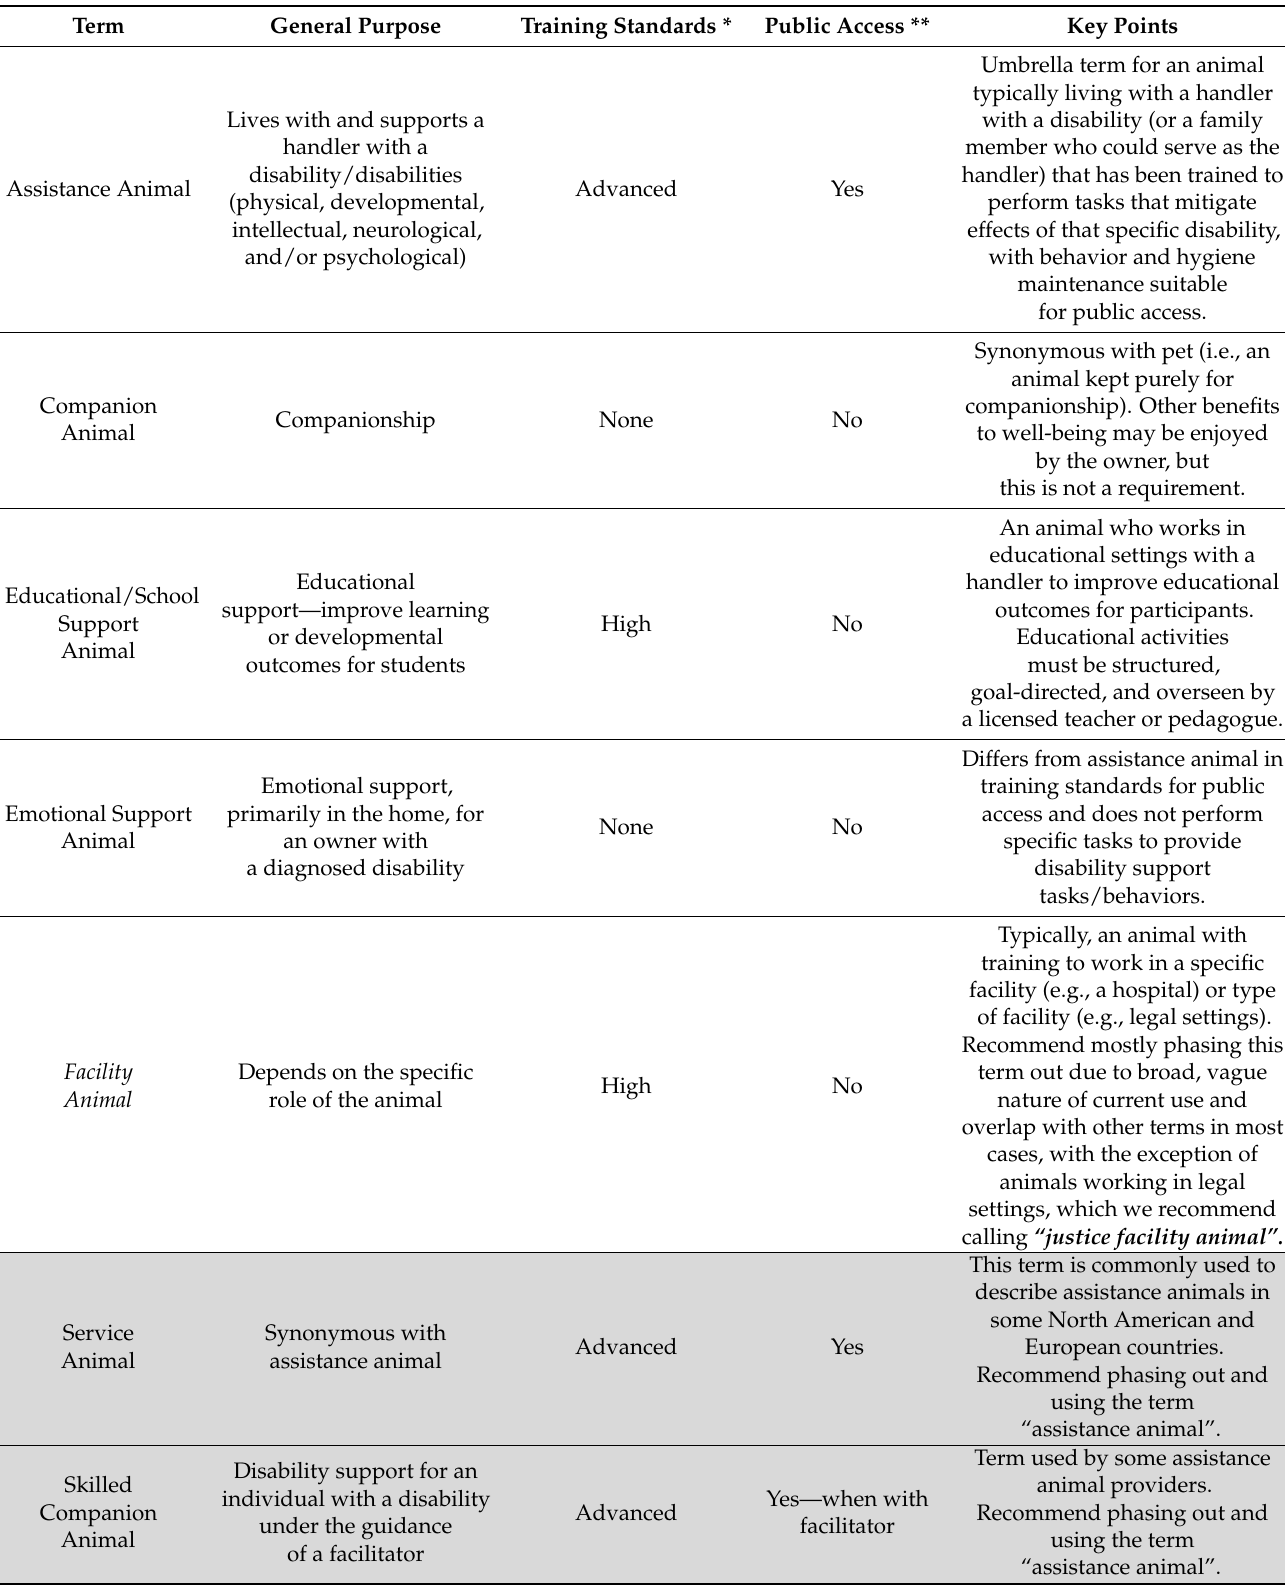
Table 1. Summary of recommended definitions for commonly used terms describing animals working in support roles for people, in alphabetical order. Terms that we recommend phasing out are shaded, and a term that we recommend modifying is